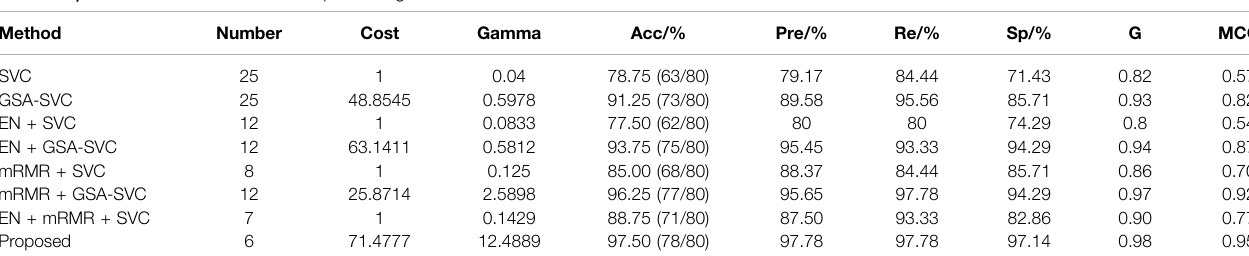
TABLE 4 | Identi fi cation results of different processing methods.